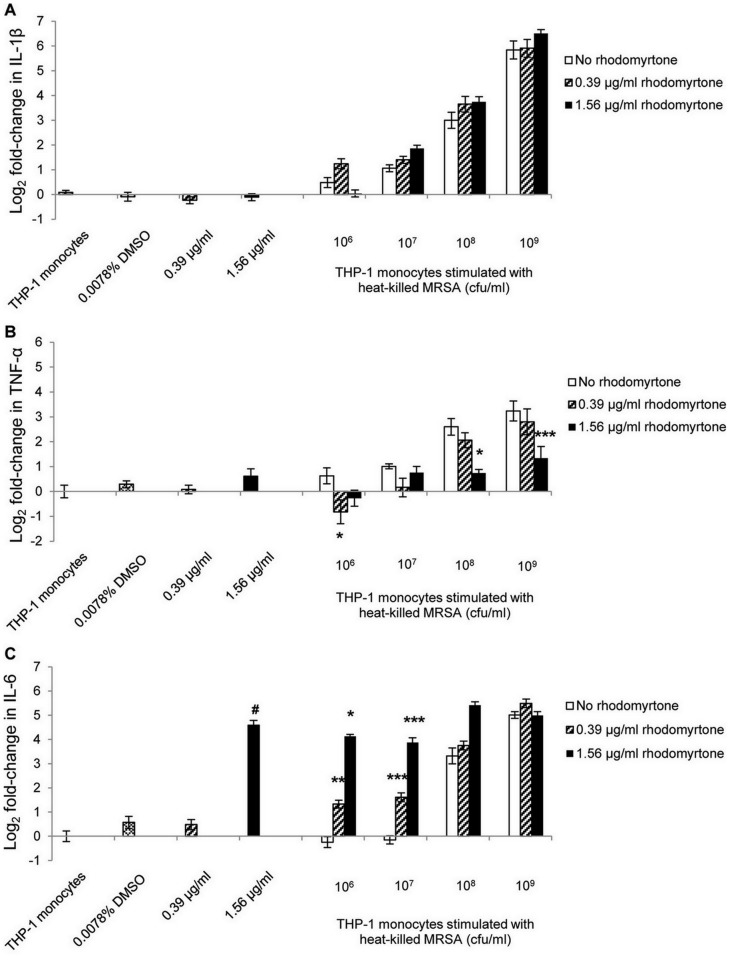
Pro-inflammatory cytokine expression by THP-1 monocytes in response to MRSA stimulation, followed by rhodomyrtone treatment.The monocytes were incubated with heat-killed MRSA at 106, 107, 108, and 109 cfu/ml, followed by rhodomyrtone treatment (0.39 and 1.56 µg/ml) for 6 h. Monocytes were collected and RNA was isolated for the measurement of mRNA levels of IL-1β (A), TNF-α (B), and IL-6 (C) by real-time PCR. Gene expression was calculated relative to β-actin gene and expressed as log2 fold change. The data are the mean ± SEM from three independent experiments and two technical replicates. p values were calculated with reference to no rhodomyrtone values at corresponding doses. * p<0.05, ** p<0.01, *** p<0.001. # p<0.001, compared with the unstimulated monocytes.